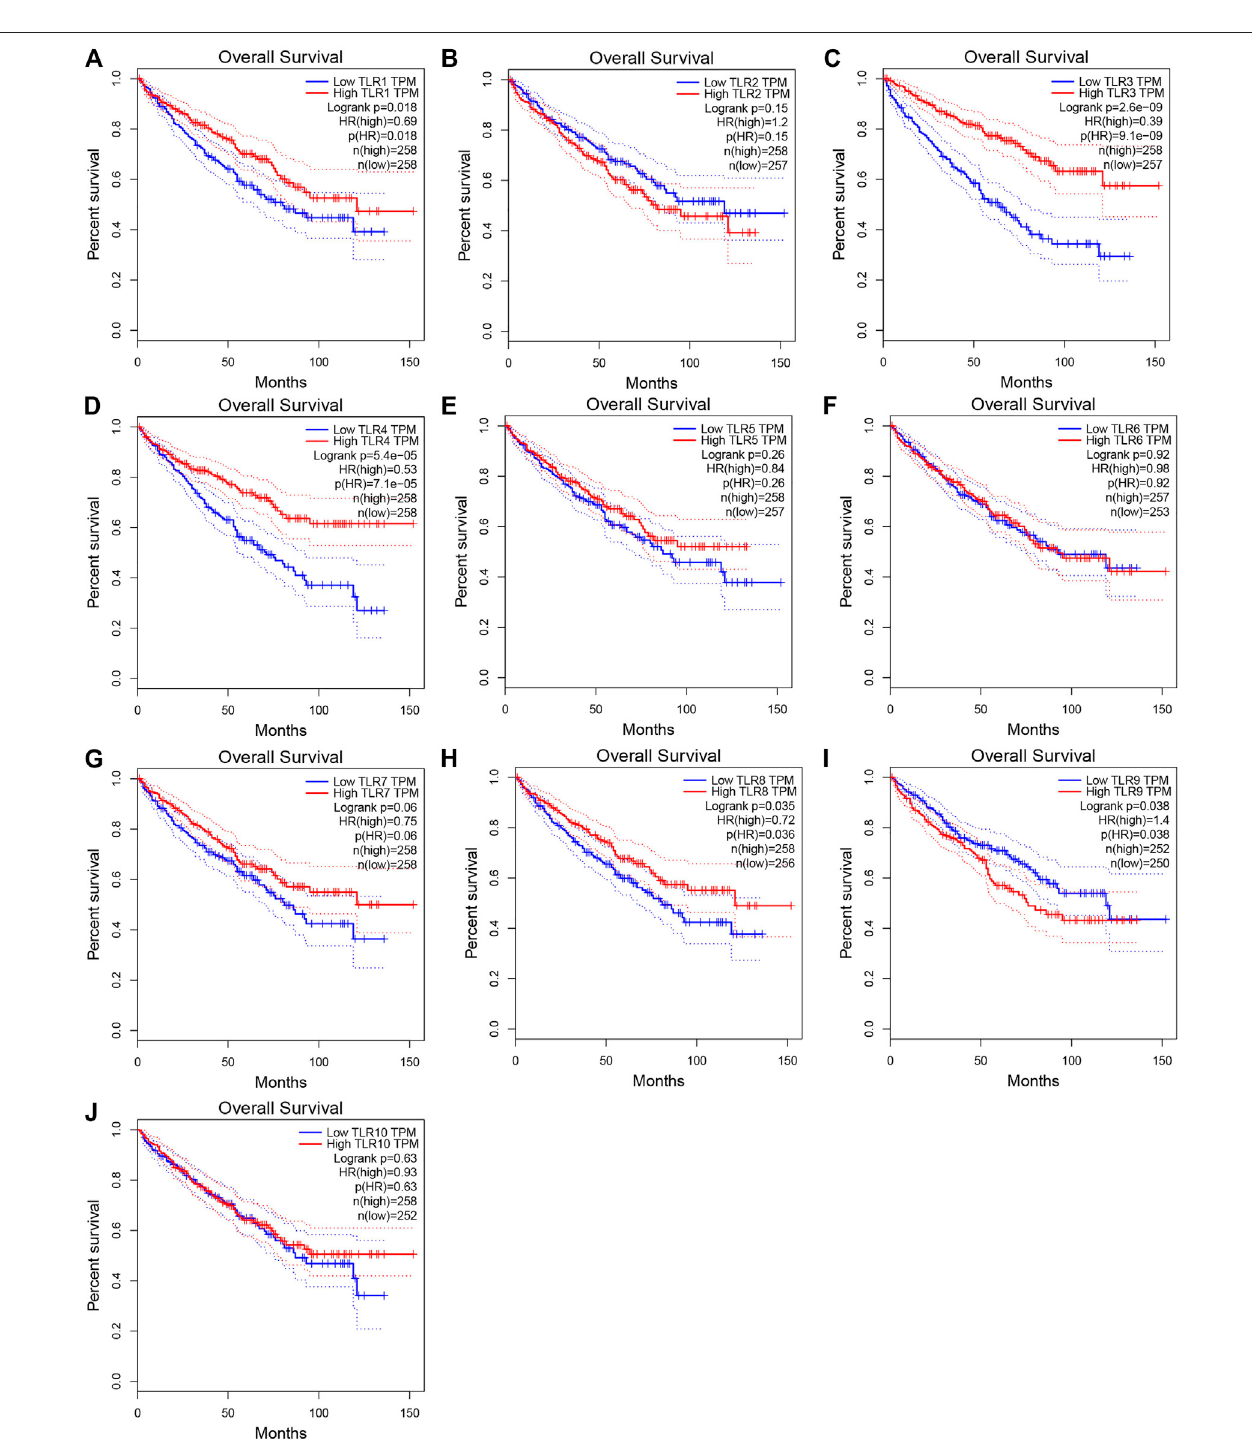
FIGURE 5 | Effects of TLRs on overall survival time of patients with KIRC. (A) TLR1, (B) TLR2, (C) TLR3, (D) TLR4, (E) TLR5, (F) TLR6, (G) TLR7, (H) TLR8, (I) TLR9, (J) TLR10.